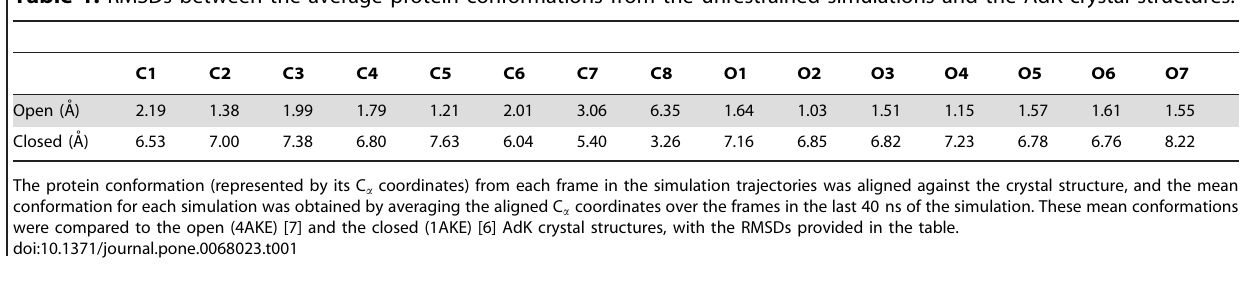
Figure 2. Time evolution of the unrestrained simulations along a conformational pathway. The pathway is represented by a ! parameterized curve X a ð Þ (see Methods). Each protein conformation X (cid:6) (cid:7) ! (see Methods), which returns the curve parameter a j corresponding to the point X operator a j ~ P a X j ! to X j . This operator was implemented through a nonlinear minimization algorithm. The projected curve parameter is plotted as a function of time for each simulation trajectory. The green and red dashed lines indicate the projected curve parameters for the open ( a =0.42) and closed ( a =0.99) crystal structures, respectively.